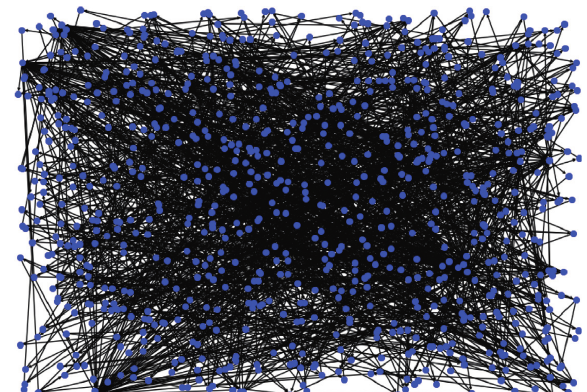
Figure 4: An AON network of a construction project with NetworkX random layout. The node size corresponds to the node degree.